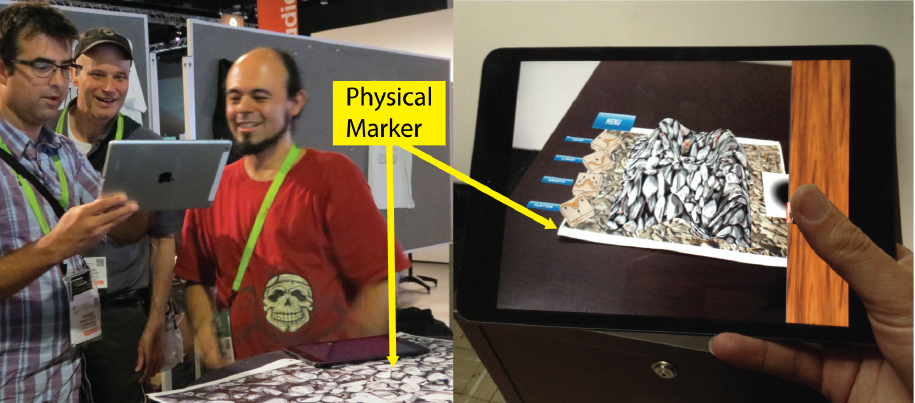
Figure 10. A snapshot of some participants of our